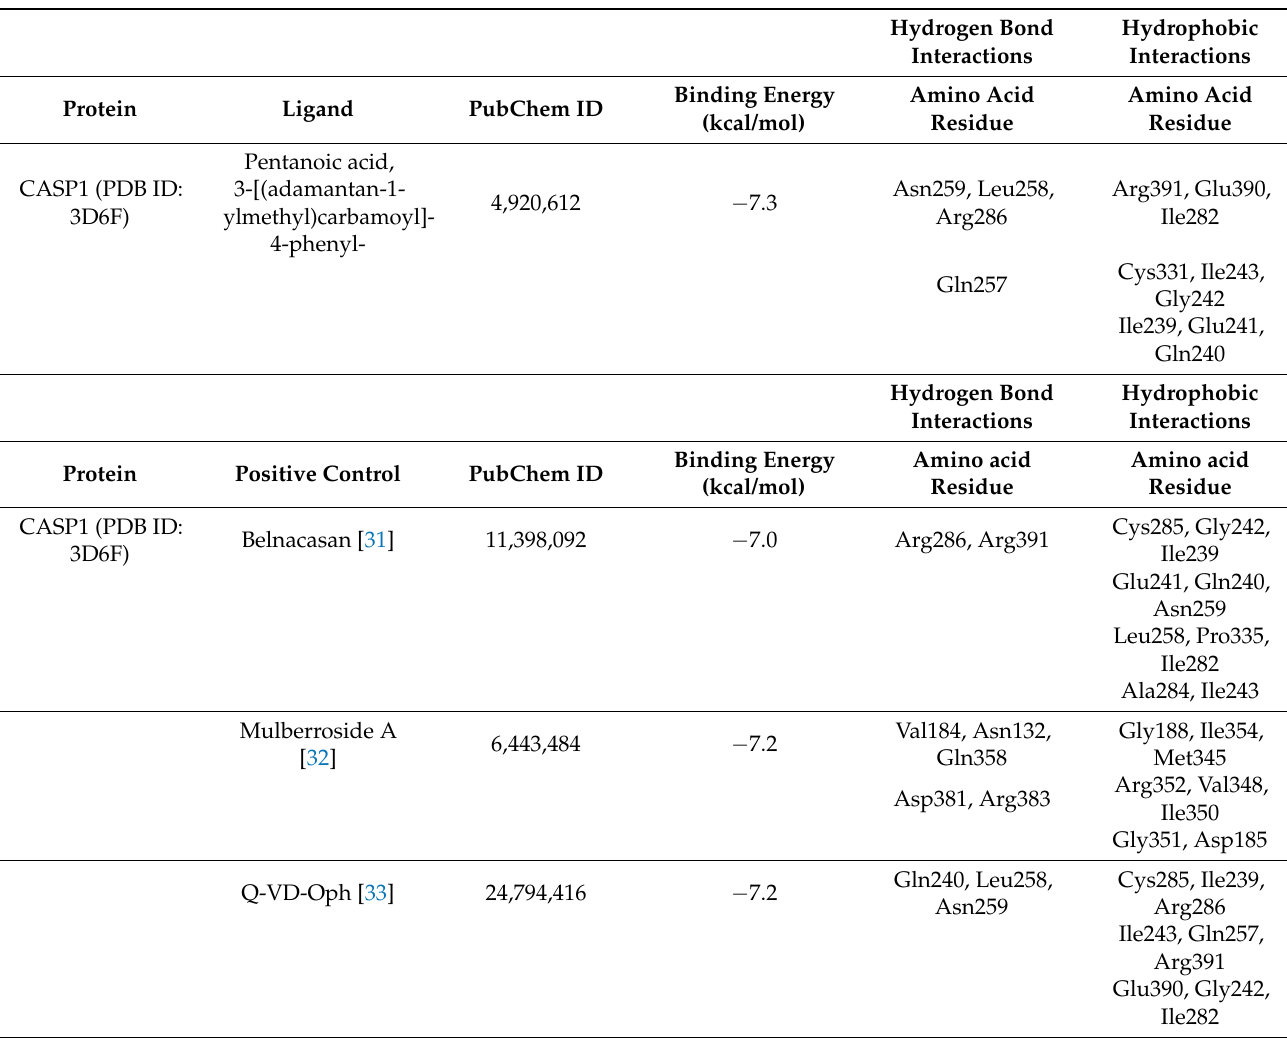
Table 8. The binding energy of potential compounds and three positive controls on CASP1 (PDB ID: 3D6F).